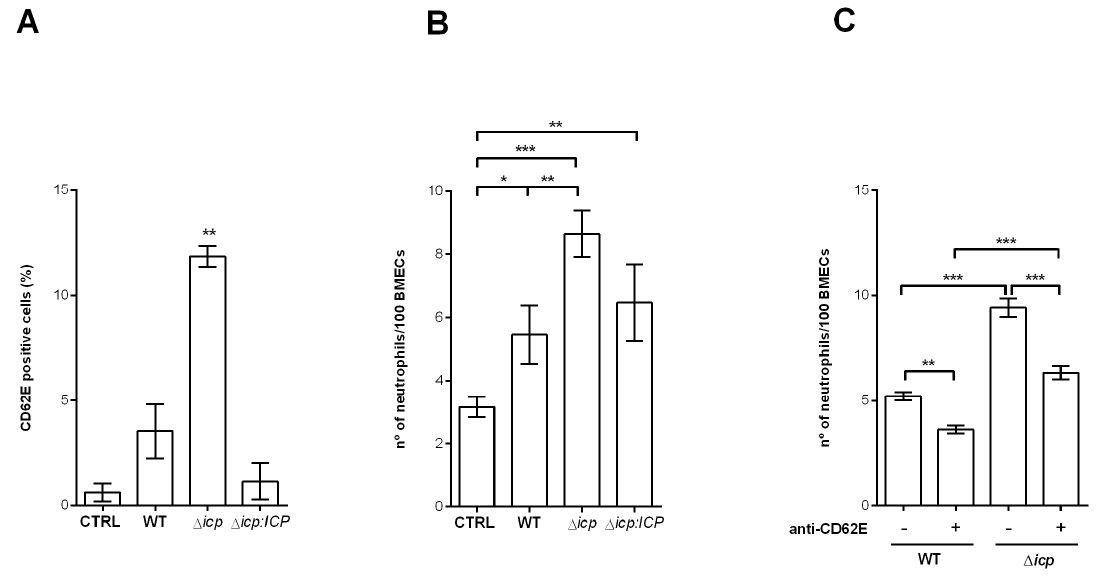
Figure 5. T. b. rhodesiense Δ icp make HBMECs more susceptible to neutrophil adhesion. ( A ) Human BMECs were cultivated for 3 days, washed, and then incubated with BSF parasites of T. b. rhodesiense WT, Δ icp , and Δ icp:ICP for 18 h. Monolayers were washed, cells were detached, and cell surface E- selectin (CD62E) was detected by flow cytometry. ( B ) HBMECs (5 × 10 4 ) were seeded on glass co- verslips and cultured for 3 days, after which BSF parasites of T. b. rhodesiense WT, Δ icp , and Δ icp:ICP were added at a 2:1 parasite:cell ratio for 18 h. Cells were then washed and 10 6 human neutrophils were co-cultivated for 1 h. CTRL refers to control HBMECs not exposed to parasites, and co-culti- vated with the neutrophils only. ( C ) Following cultivation on coverslips, HBMECs were exposed to parasites, washed, incubated with anti-E-selectin antibody for 1 h and washed, prior to the addition of neutrophils, as above. After incubation with the neutrophils, cells were washed, fixed with 70% methanol and then Giemsa stained. The number of adhered neutrophils was determined by the counting of 100 HBMECs per coverslip under a light microscope. The experiments were performed in triplicate, ( B ) five independent times or ( C ) two independent times, and data are shown as the mean ±SD of a representative experiment. In ( A ), asterisks indicate significance to all other points. Asterisks indicate statistical significance at p < 0.05 (*), p < 0.01 (**), and p < 0.001 (***) as assessed by one-way ANOVA with Tukey’s post hoc